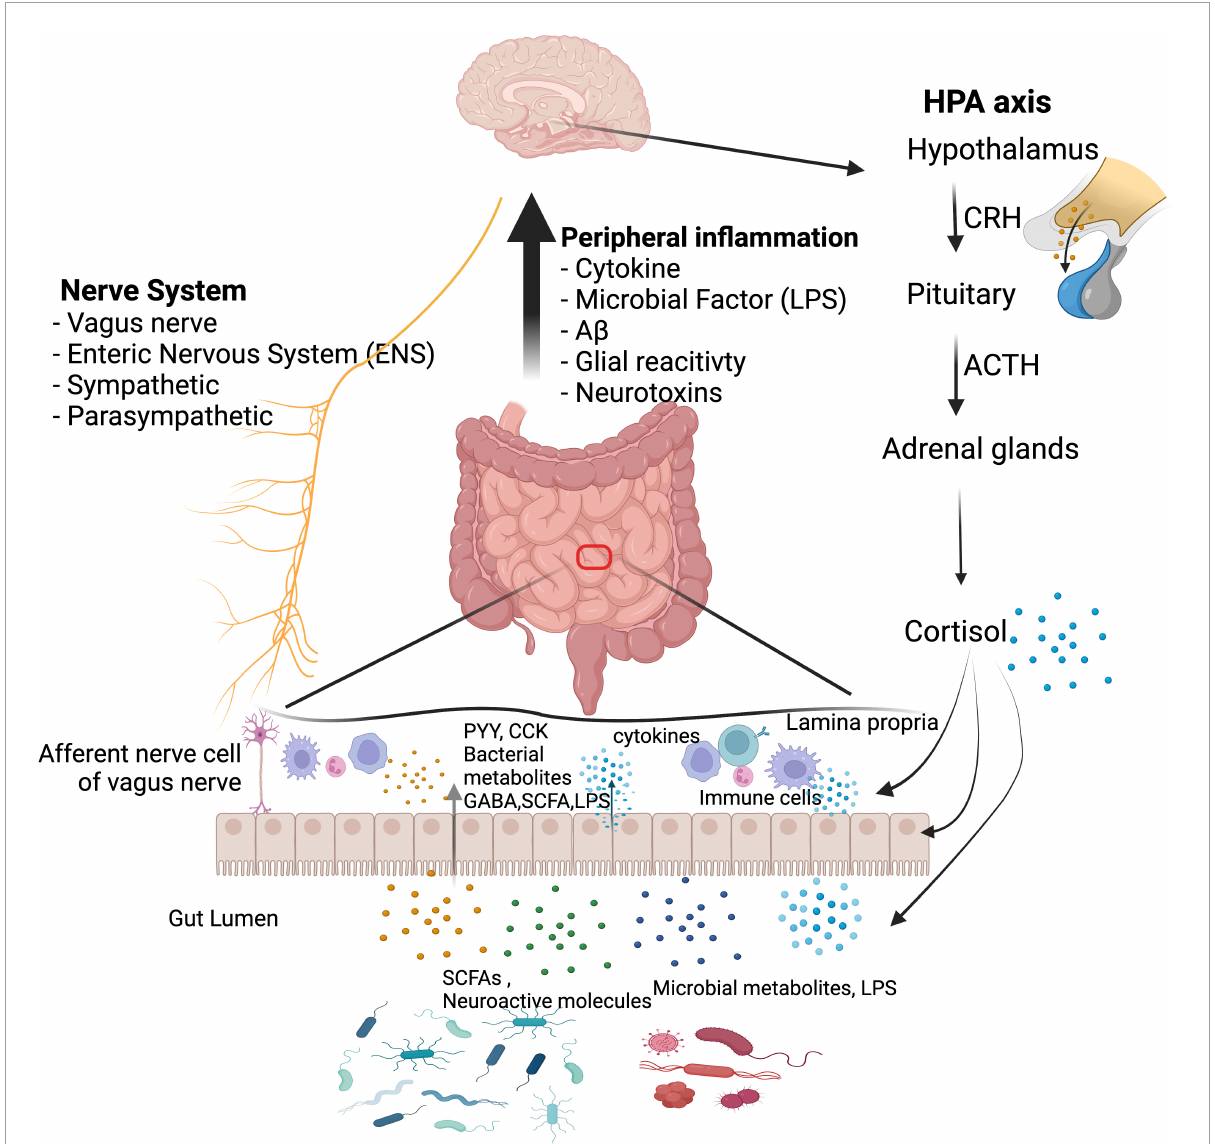
FIGURE2 Communication networks between the gut microbiota and the brain. Communication pathways include immunological, neural, and hormonal pathways, which can function collectively: (1) MAMPs can activate both the peripheral and the central immune system; (2) microbial metabolites reach the brain to regulate neurological health; (3) a bidirectional influence is established between the CNS and the gut microbiota through the vagus nerve and the enteric nervous system; (4) interactions with the HPA axis regulate brain function and gut microbiota composition.